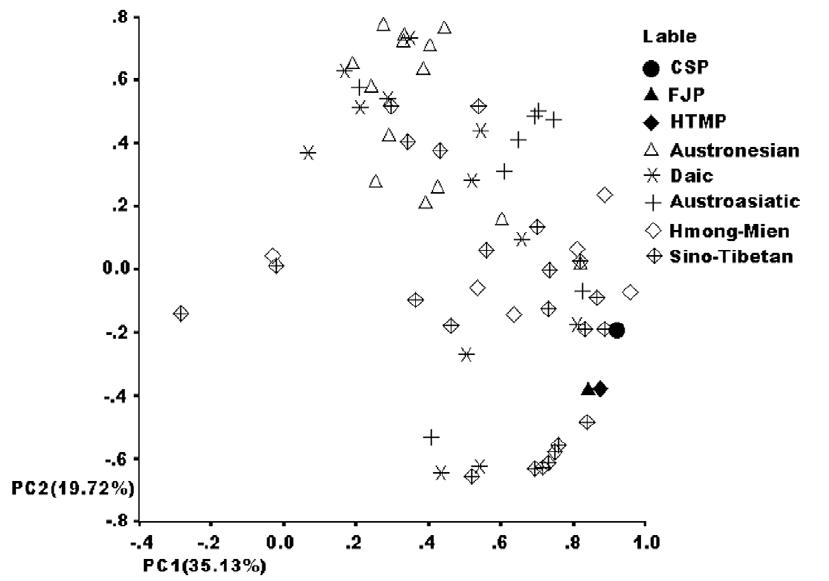
Figure 4. Principal component dot plot of Y-chromosome haplogroups. Chaoshan, Henan Taihang Mountain and Fujian EC high-risk populations are clustered together and located among Sino-Tibetan populations, which suggests a close genetic relationship among them. doi:10.1371/journal.pone.0011118.g004 PLoS ONE |